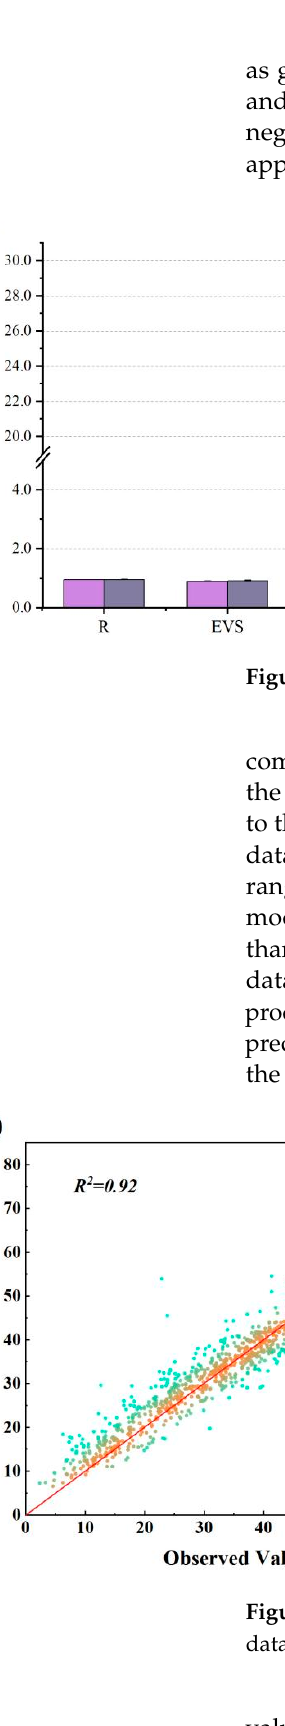
Figure 9. Relative frequencies of observed and predicted compressive strength ratios CS (cid:2925)(cid:2912)(cid:2915) / CS (cid:2926)(cid:2928)(cid:2915) : ( a ) of dataset 1 and ( b ) of dataset 2. 3.2. Sensitivity Analysis of Input Variables Having obtained an accurate compressive strength prediction model, it is crucial to understand which variables have a major impact on the compressive strength of high- performance concrete. Sensitivity analysis was performed in this study by changing one input variable at a time while keeping the others constant [51]. The predicted output was recorded as the specific variable was changed—the greater the effect of the changing var- iable on the output, the higher the importance score of that variable. The same procedure was repeated for each of the input variables. After obtaining the importance scores for all inputs, the values were normalized so that their summation was equal to 1, with the nor- malized importance scores shown in Figure 10. The authors note here that a sensitivity